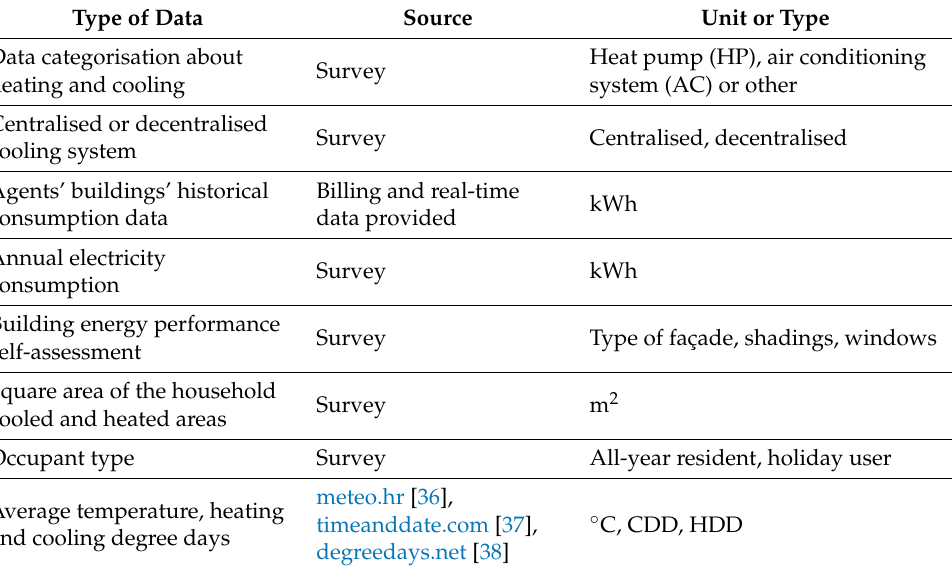
Table 1. Summary of the case study data